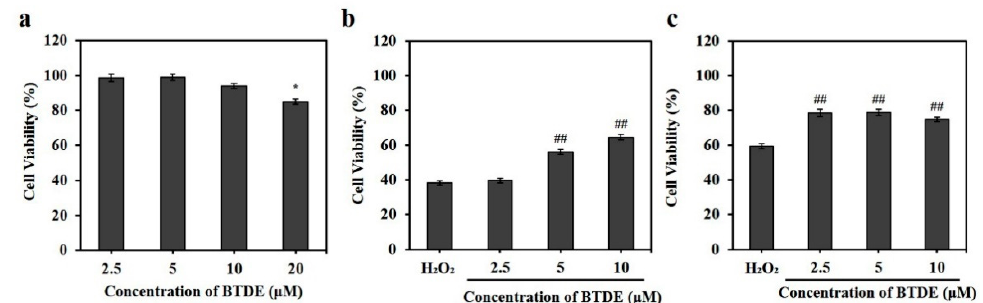
Figure 2. BTDE reverses oxidative damage in HaCaT and HUVEC cells. ( a ) The effect of BTDE on the viability of HaCaT cells. HaCaT cells were treated with different concentrations (2.5–20 µ M) of BTDE for 24 h, and cell viability was then determined using the sulforhodamine B (SRB) method. ( b ) The effect of BTDE on the viability of HaCaT cells damaged by H 2 O 2 . HaCaT cells were incubated with BTDE for 24 h and then were treated with H 2 O 2 for 3 h. Finally, cell viability was determined by the SRB method. ( c ) The effect of BTDE on the viability of HUVEC cells damaged by H 2 O 2 . HUVEC cells were incubated with BTDE for 24 h and then were treated with H 2 O 2 for 3 h. Finally, cell viability was determined by the SRB method. Values are expressed as mean ± SD of three independent experiments. * p < 0.05, versus control group, ## p < 0.01, versus H 2 O 2 alone.